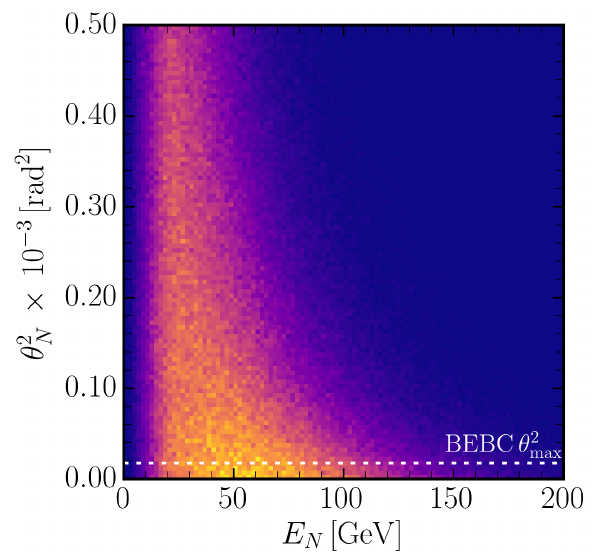
= 1 GeV, against the N